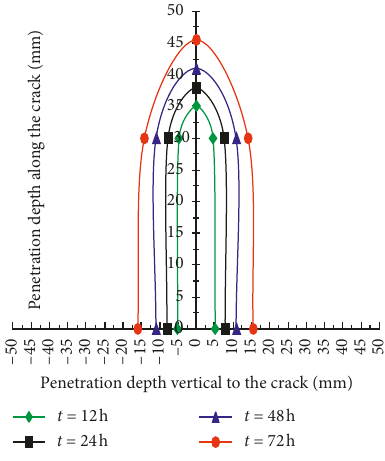
Figure 6: Penetration depth map of working conditions